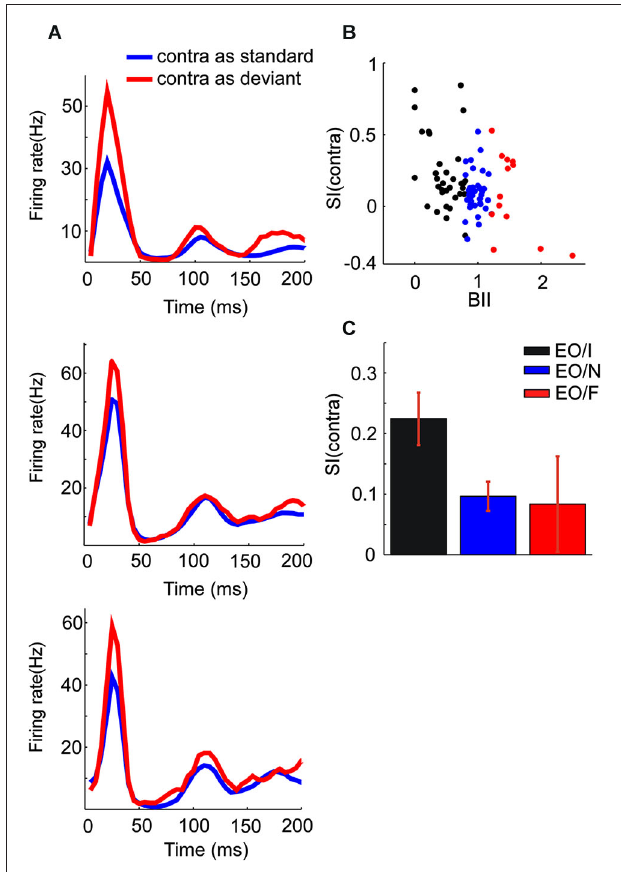
FIGURE 4 | Population responses of subgroups of EO neurons. (A) PSTH showing the mean responses of EO/I (top), EO/N (middle) and EO/F (bottom) neurons in the oddball paradigm when presented to the contralateral ear. (B) The scatter plots the SI of three kinds of EO neurons vs. BII (binaural interaction index). There are three dots of which x value equaling 0 because they did not respond at all when the stimuli were presented to binaural ears. (C) Average SI of the classes of EO neurons (mean ± s.e.m., 0.224 ± 0.043, p < 10 − 5 ; 0.097 ± 0.024, p < 10 − 3 ; 0.084 ± 0.079, p = 0.312 for EO/I, EO/N and EO/F respectively, t -test).